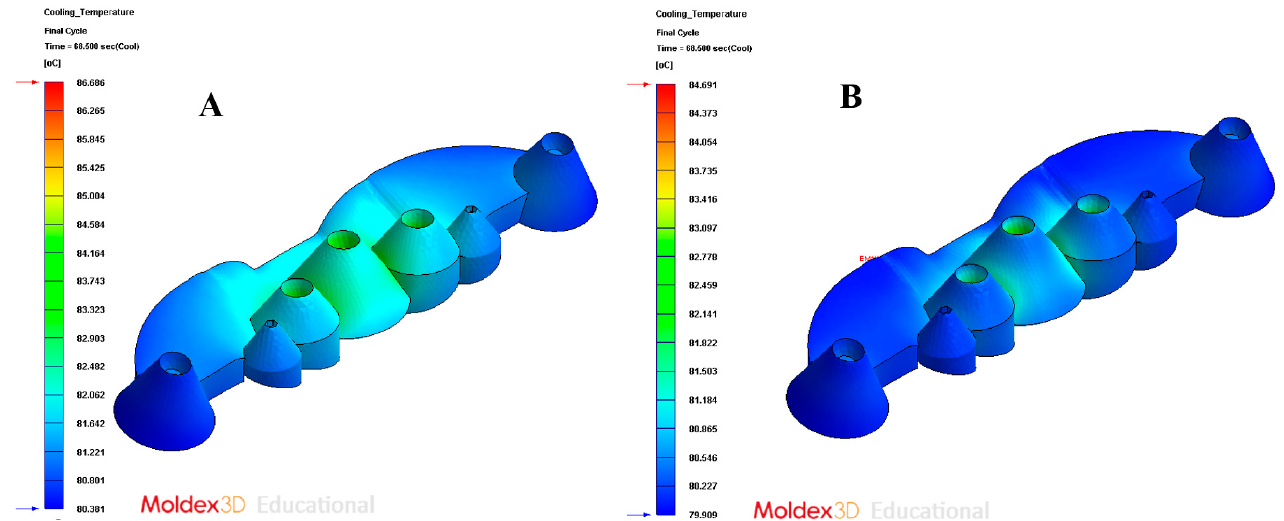
Figure 21. Cooling temperature. ( A ) Traditional cooling; ( B ) conformal cooling.